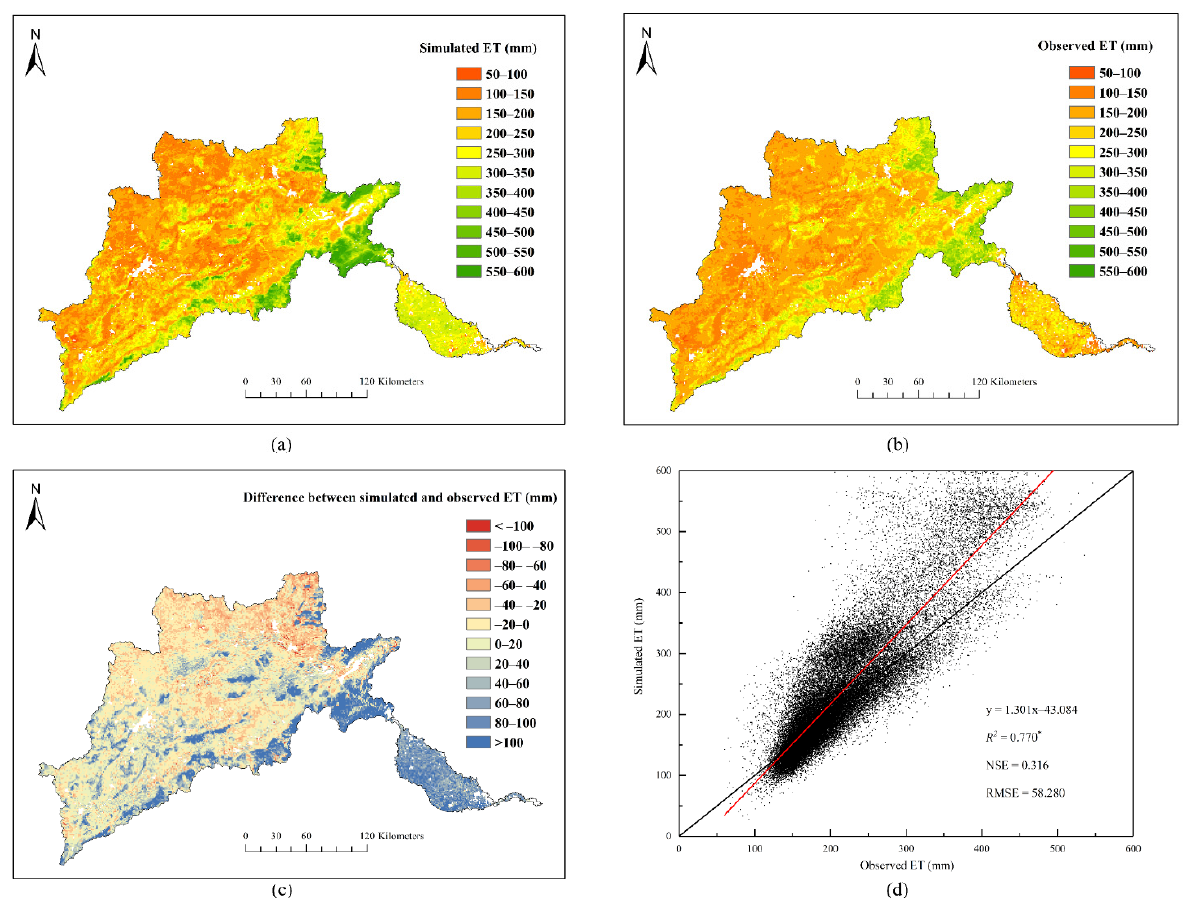
Figure 4. Comparison of the average simulated evapotranspiration (ET) versus the average observed ET during the growing season from 2000 to 2018. Spatial distribution of simulated ET in ( a ); spatial distribution of observed ET in ( b ); difference between simulated and observed ET in ( c ); scatterplot of simulated and observed ET in ( d ), in which the sample capacity was 47690. * represents significance at a level of 0.05.